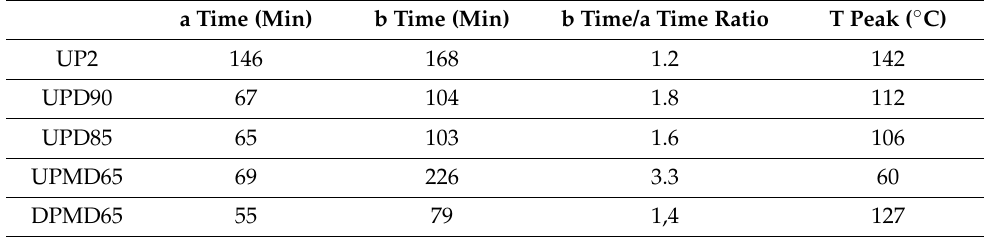
Table 10. Reactivity parameters of